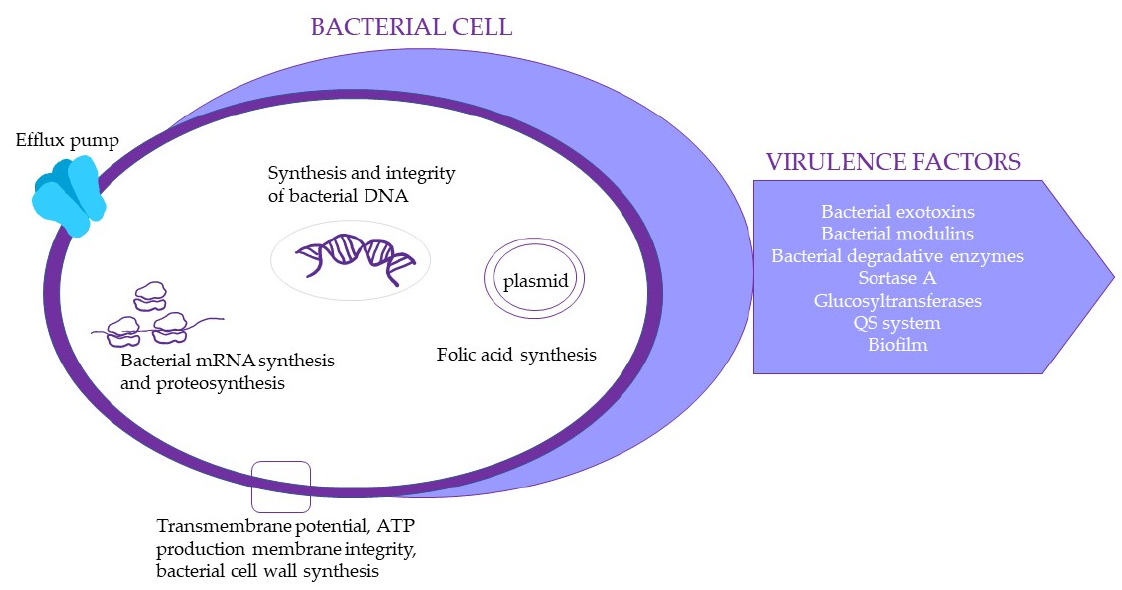
Figure 2. The bacterial molecular targets for tannins and flavonoids antibacterial action [21,29]. Oligomeric proanthocyanidins inhibit interleukins IL ‐ 1 β , IL ‐ 6, IL ‐ 8, PLA 2 , lipo ‐ and